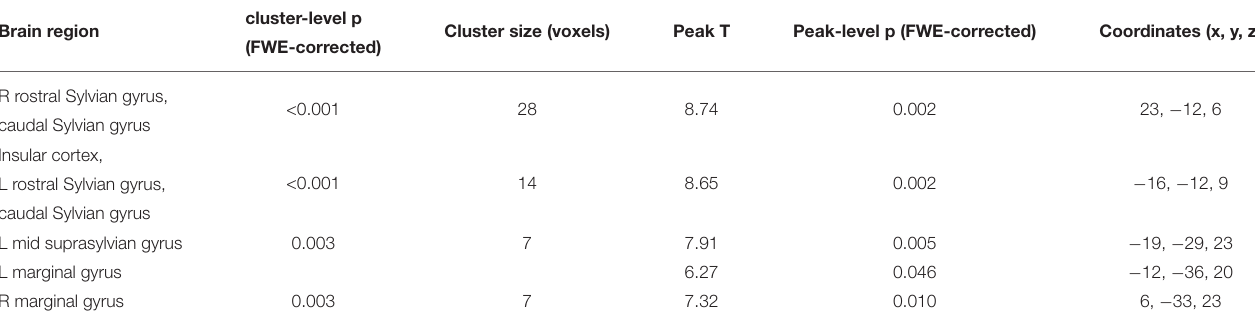
TABLE 1 | Main GLM results for Study 1 with a threshold of peak-level uncorrected p < 0.0001, showing the results of the face > controll contrast. cluster-level Brain region